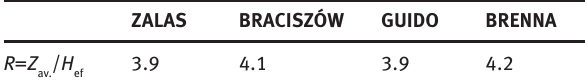
for different types of rocks. ef